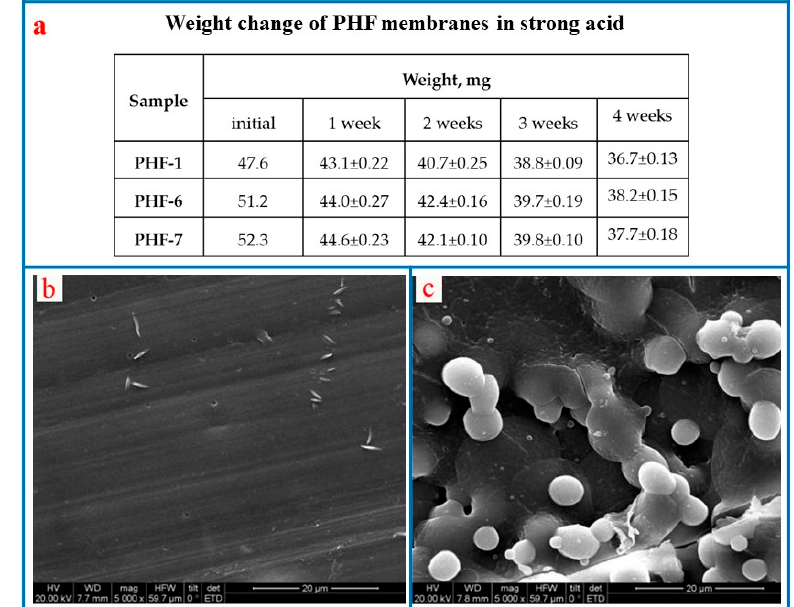
Figure 7. Degradability of PHF membranes in acid solution. ( a ) weight loss rate of PHF membranes in strong acid solution; ( b ) SEM images of PHF-7 before treatment by strong acid; and, ( c ) SEM images of PHF-7 after treatment by strong acid.